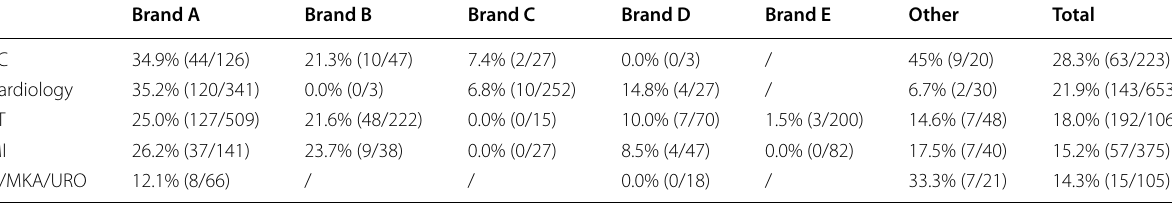
Backslashes indicate